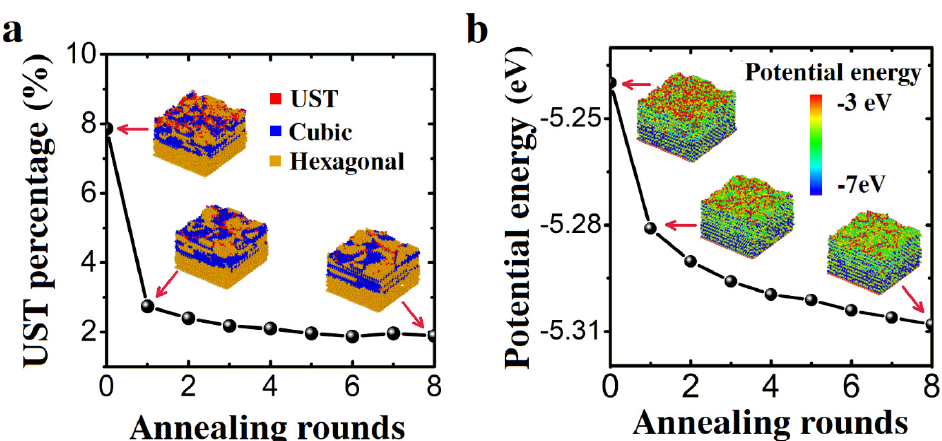
Figure 4. Structure evolution with respect to the number of annealing rounds. UST (unidentified structure-type) atoms’ percentage and average potential energy of the Sample A after different rounds of annealing at 4000 K. ( a ) UST atoms’ percentage and crystal structures (insets) of sample A. ( b ) The average potential energy and the spatial distribution of the potential energy (insets) of sample A after different rounds of annealing.